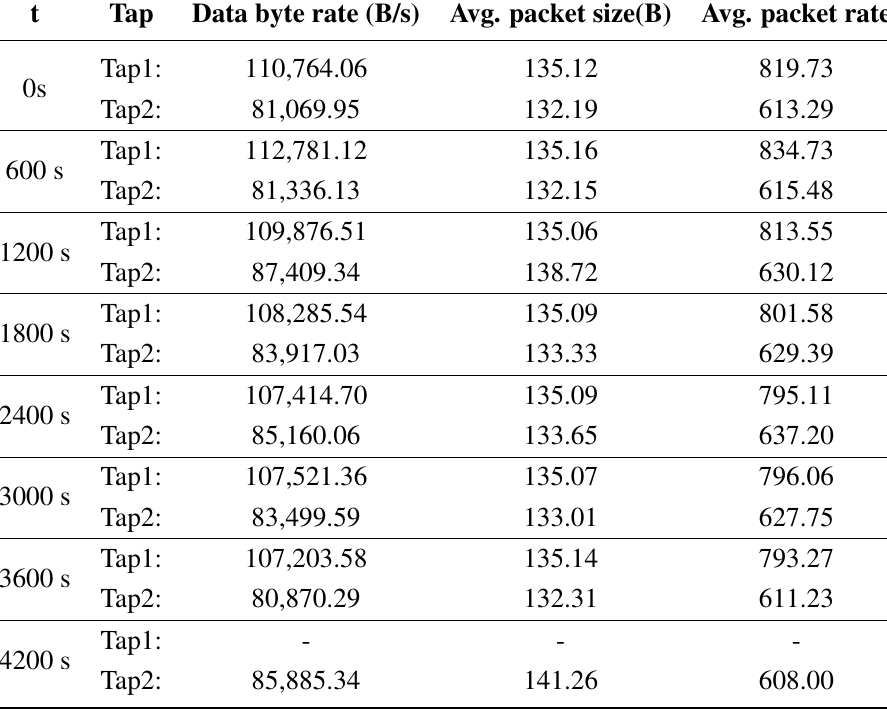
Table 2. Statistics of the 600 s interval slices of the packet captures.